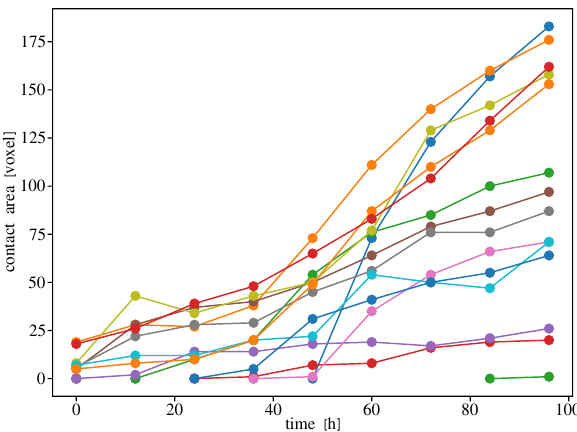
Figure 7. Time evolution of the contact areas of a grain with its neighbours. Not only the existing contacts tend to increase in size, but also new contacts generate during the exposition to high RH under constant